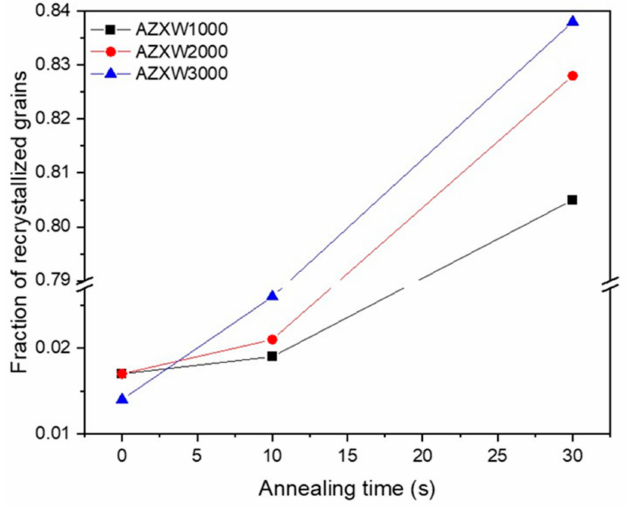
Figure 9. Fraction of the recrystallized grains of the AZXW1000, 2000, and 3000 alloys according to the annealing time calculated from the IPF maps in Figure 7.